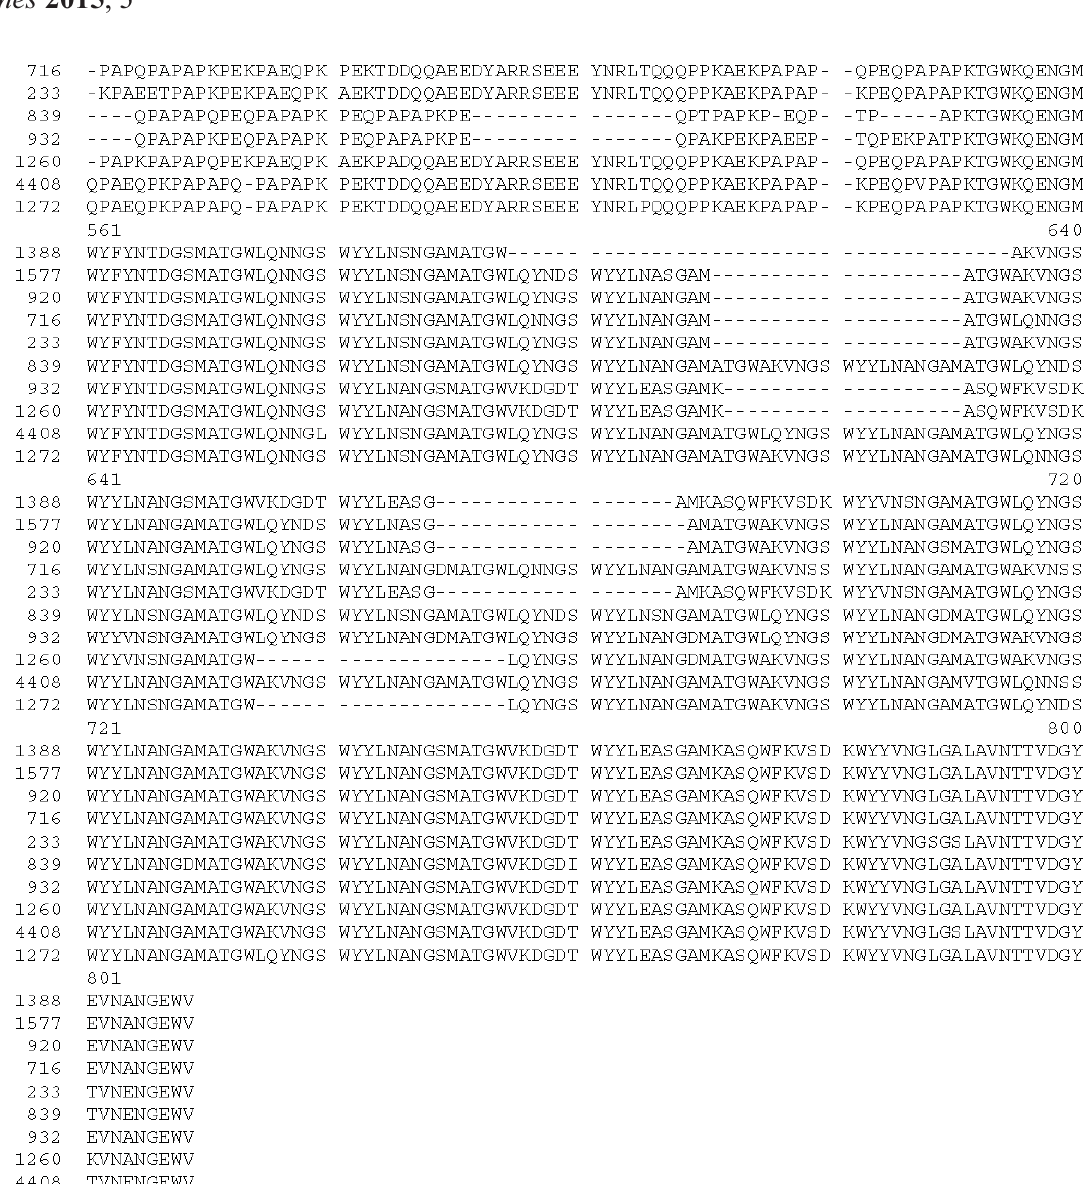
Figure A3. Alignment of deduced amino acid sequences of PspA of the tested S. pneumoniae clinical isolates. The alignment was performed with Multalin (http://multalin.toulouse. inra.fr/multalin/multalin.html). Gaps were inserted to give the best